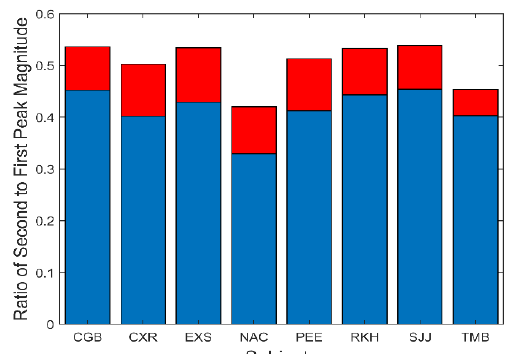
Figure 10: The magnitude of the first harmonic (i.e., second peak) was on average less than half that of the fundamental. Mean is plotted in blue and standard deviations is plotted in red.